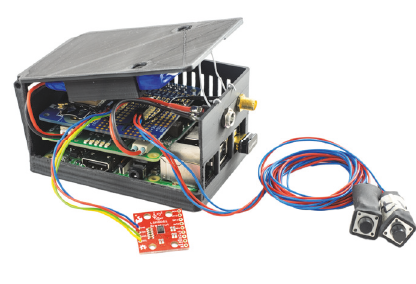
Figure 2: Measurement unit, consisting of Raspberry Pi, inertial sensor, Adafruit ultimate GPS Hat, UPS Hat, and two buttons for labeling the data. In service, the inertial sensor is fixed under the Raspberry Pi on the bottom of the case. The case is cut open for visualization purposes.